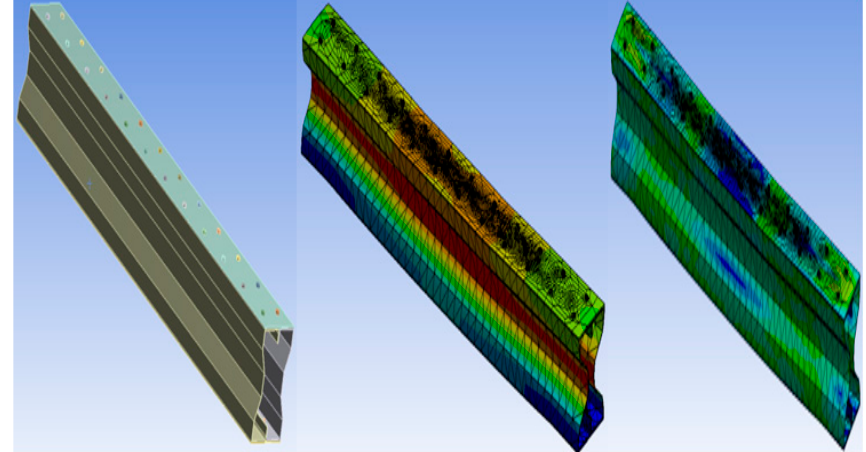
Figure 4. Buckling and stress distribution of F2F100.